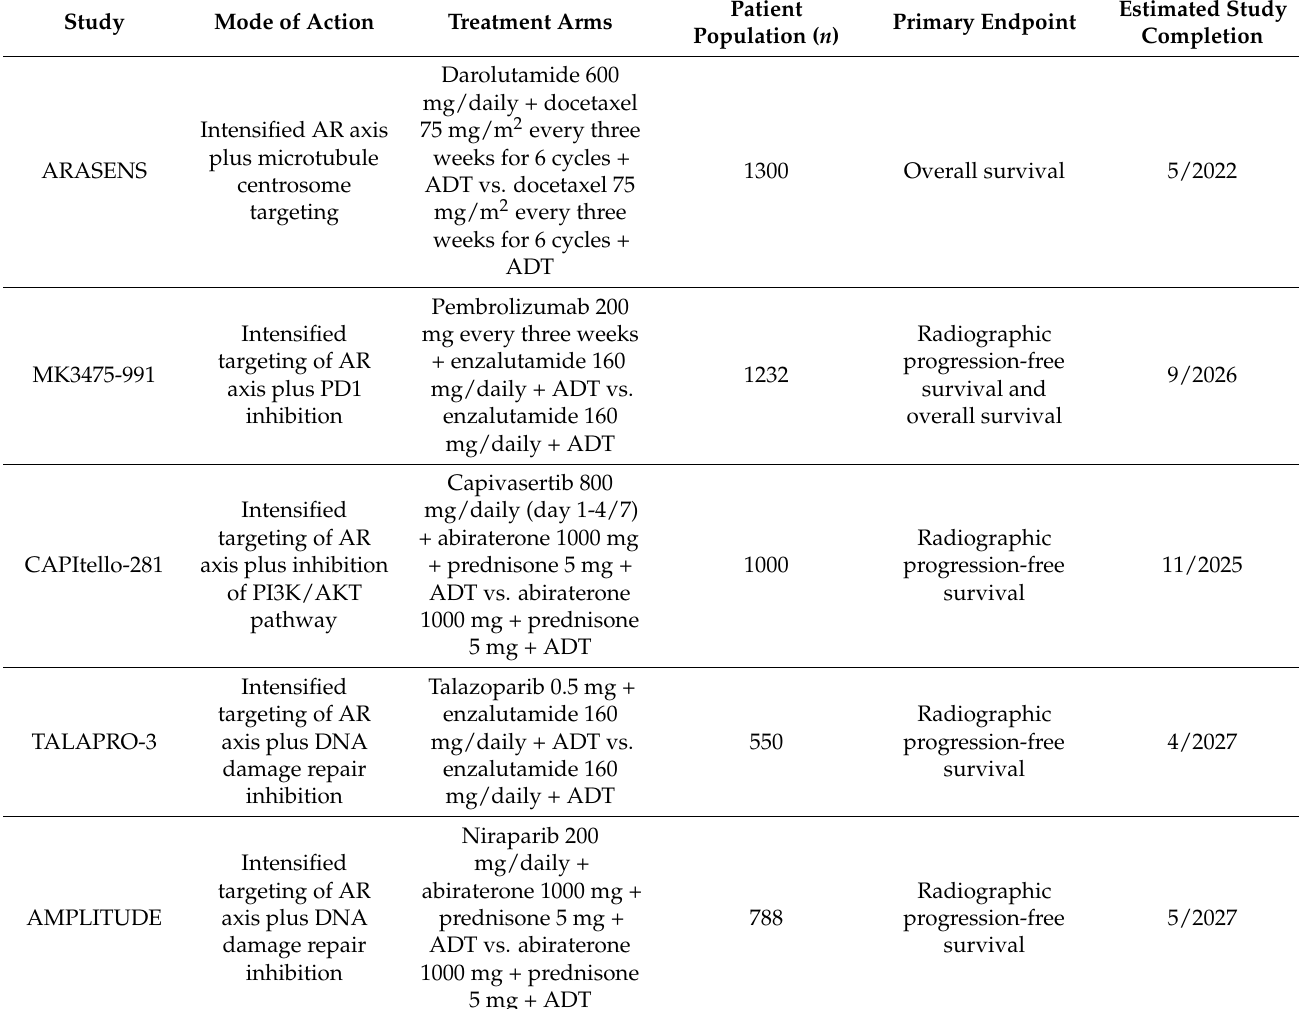
Table 3. Ongoing phase III studies for triple therapy in